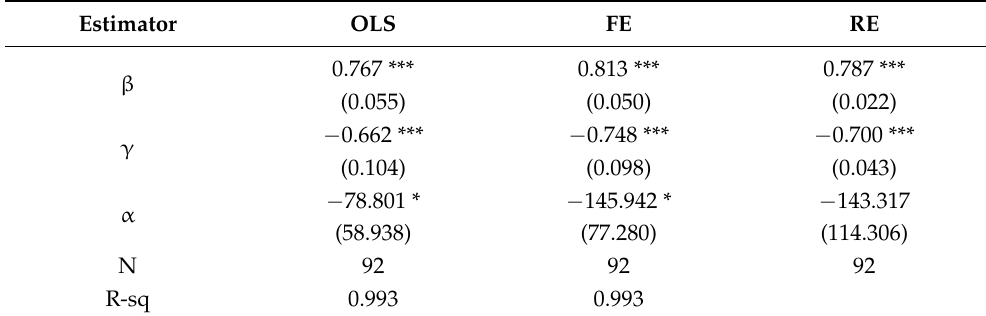
Table 2. Parameter estimation of the regression equation.